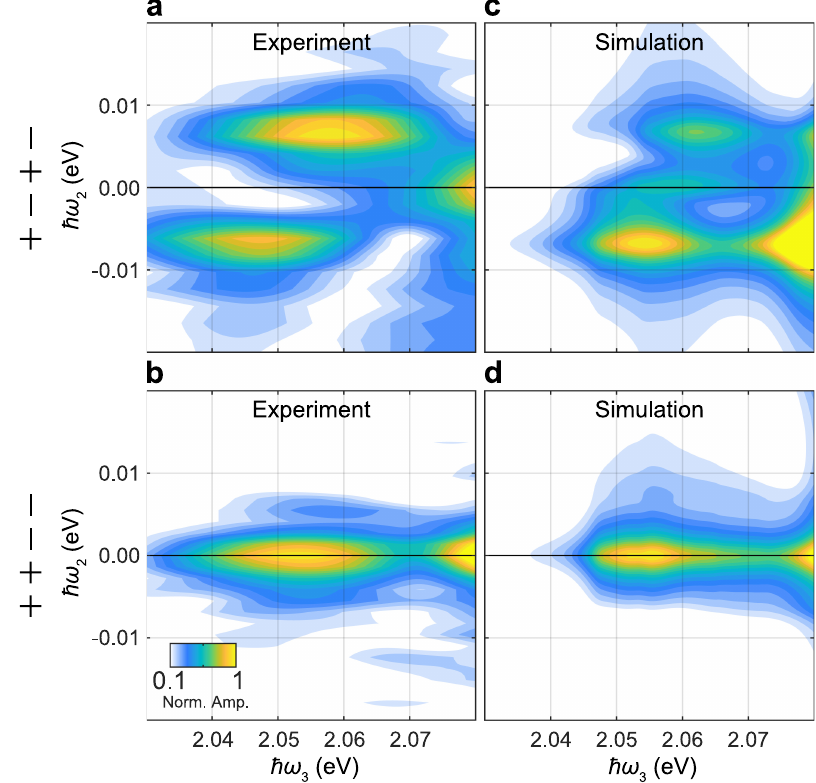
Fig.3|Zero-quantum2Dspectracon fi rmsignalorigins.a , b Experimental0Q2D energies, indicating thatthe pathways leading to thebipolaron peaks also proceed spectra with t 1 =50fs for the σ + σ − σ + σ − and σ + σ + σ − σ − polarization sequences. Color viathesecoherencesforthe σ + σ − σ + σ − case,andviapopulationstatesforthe σ + σ + σ − σ − case. c , d Thecorresponding simulated 2Dspectrausingthepolaronmodel.These scaling represents the normalized absolute signal amplitude (Norm. Amp.). (Plots peaks do not extend to low ℏ ω 3 values like they do in the experimental over the full energy range are shown in Supplementary Fig. 5). The peaks at ∣ T *" ih S +" ∣ and ℏ ω 2 =±7meVin a indicatethatinthiscasethesystemevolvesviathe ℏ ω ∣ S *# ih T +# ∣ coherences in t 2 . In b there is only a peak at 2 =0, as expected for the population pathways driven by the σ + σ + σ − σ − pulse sequence, detailed in Supple- mentaryFig.6.Inbothcasesthepeaksextendbelowthesingletandtripletpolaron